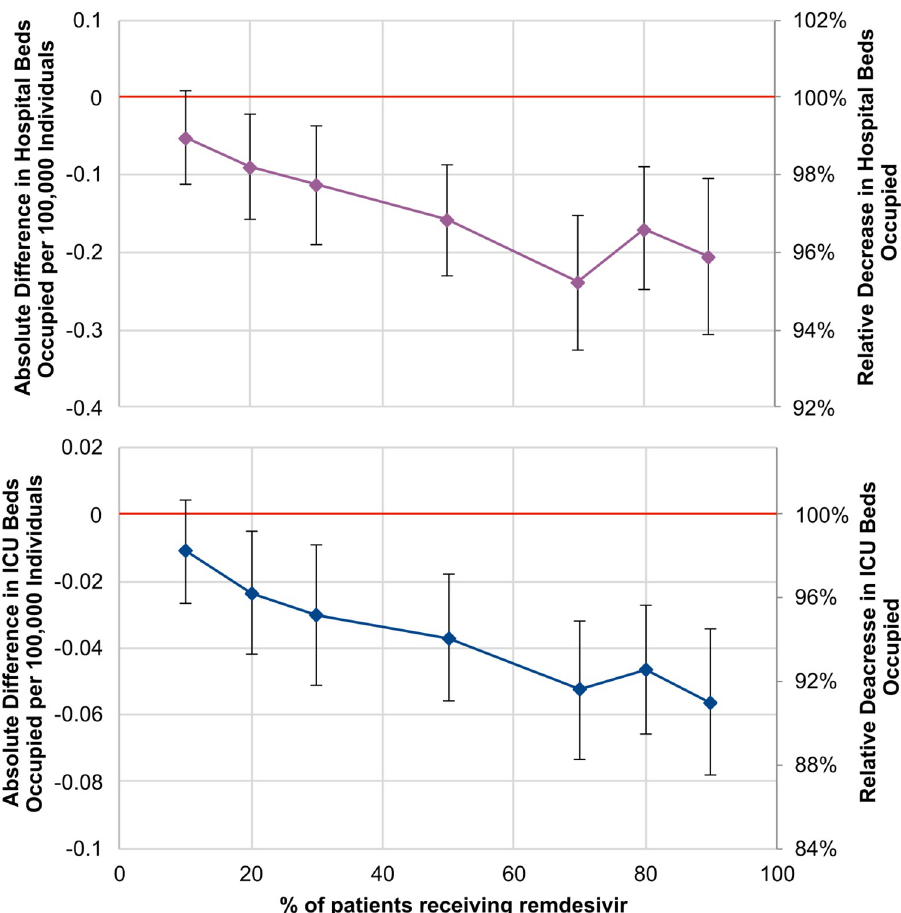
Fig 3. Estimations of the total number of hospital bed-days occupied (top) and total number of ICU bed-days occupied (bottom) between 01/08/2020 and 01/02/2021 associated with different rates of remdesivir use for all eligible patients with low-flow-oxygen therapy since 01/08/2020 relative to the current standard of care in France. Results are per 100,000 inhabitants. Remdesivir use has been limited to all eligible low-flow-oxygen patients since 01/08/2020. The stochastic nature of the model may be responsible for the small variations.